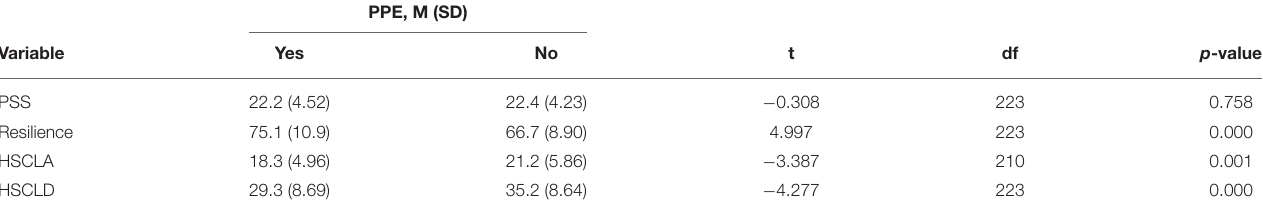
Table 3 | Independent t -test results of the PSS*, RSN*, HSCLA*, HSCLD*, and personal protection equipment (PPE*). PPE, M (SD) Variable Yes